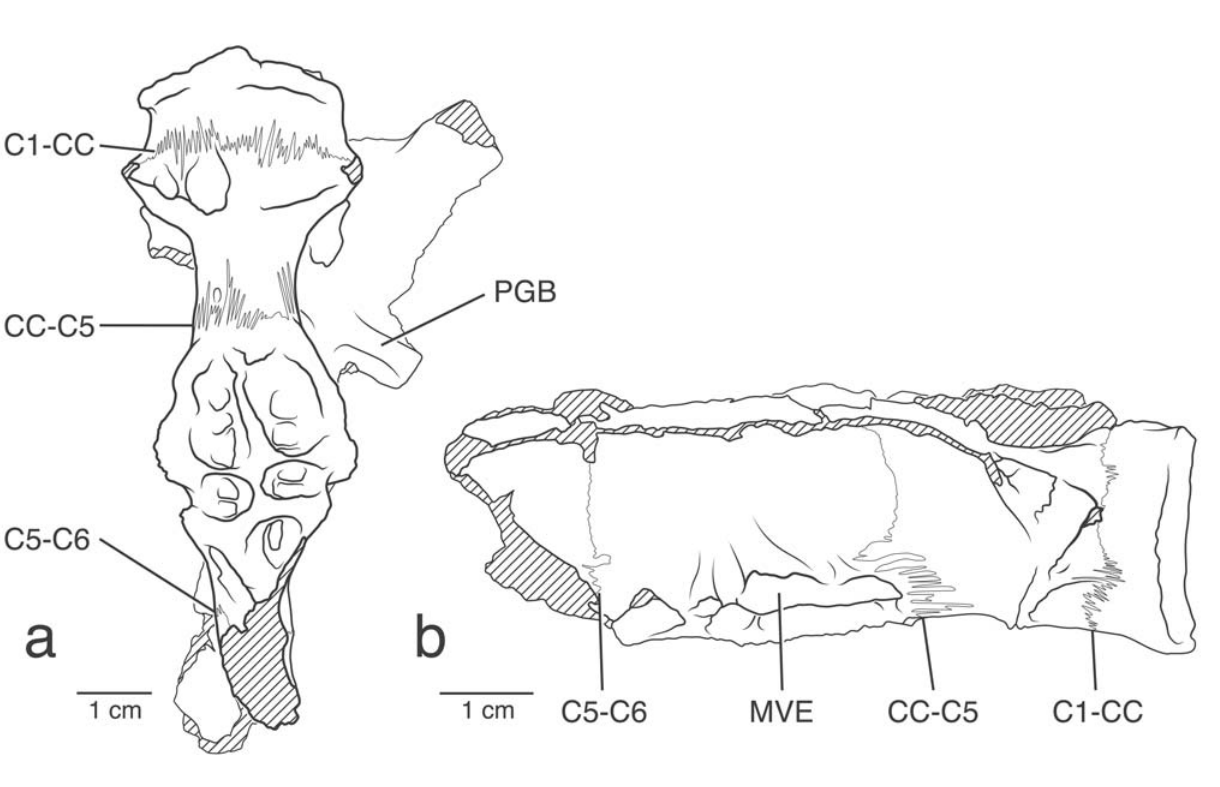
Fig. 3. Weberian complex of the fossil Brachyplatystoma promagdalena , IGM183062; a, ventral view, b, right lateral view. Abbreviations as in Figs. 1 and